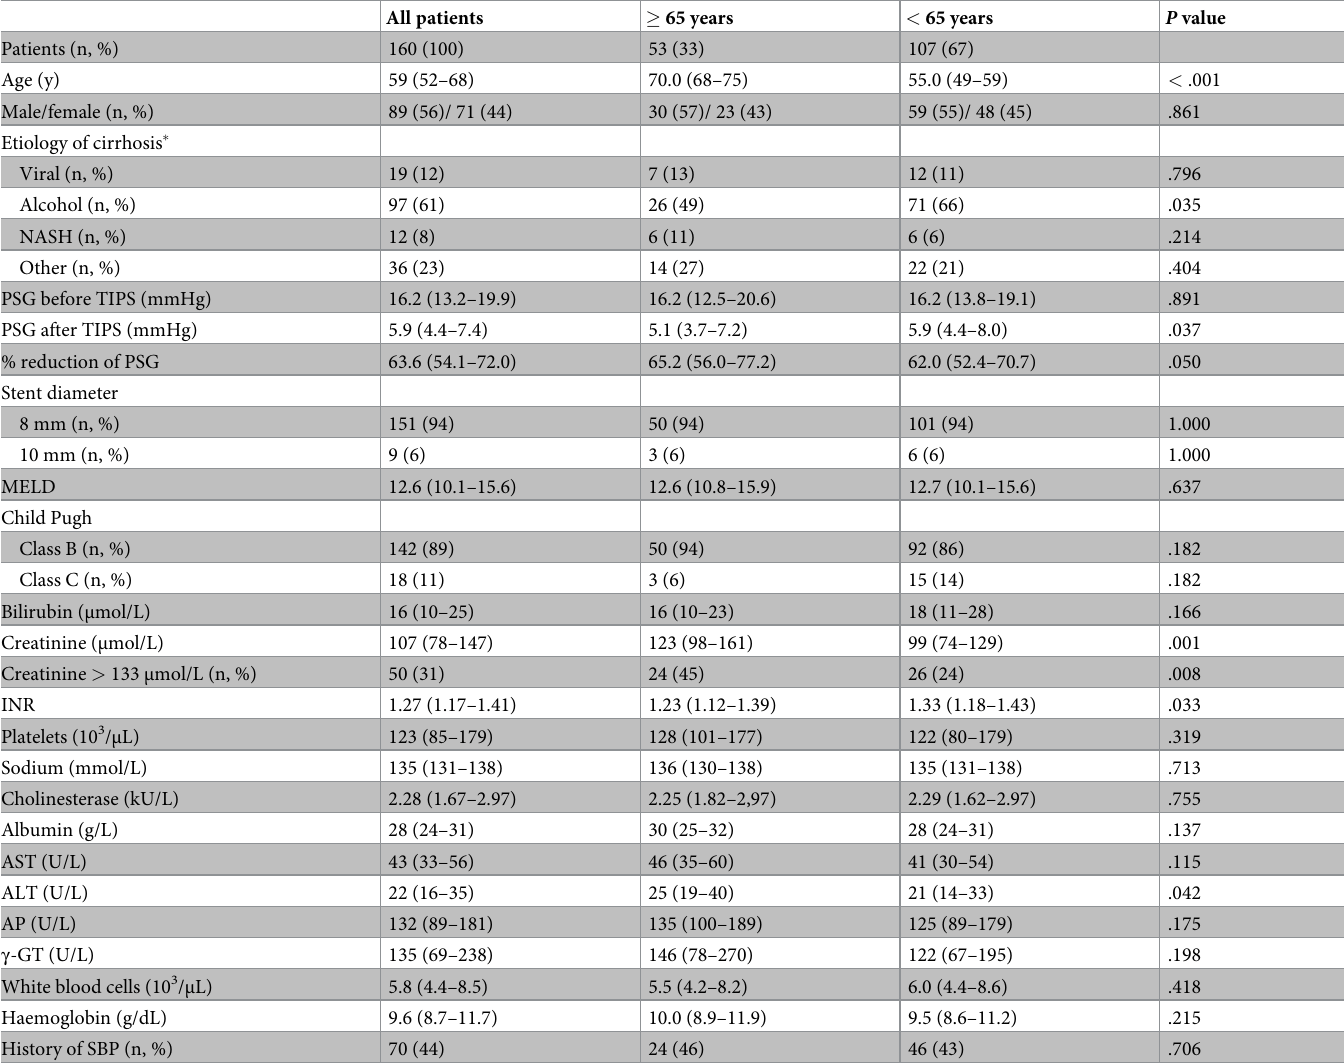
Table 1. Baseline characteristics of TIPS